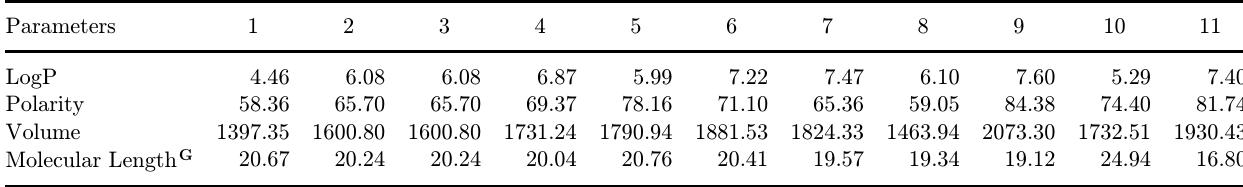
Table 2. LogP, polarity, volume and molecular length of 1{11 from molecular calculation.